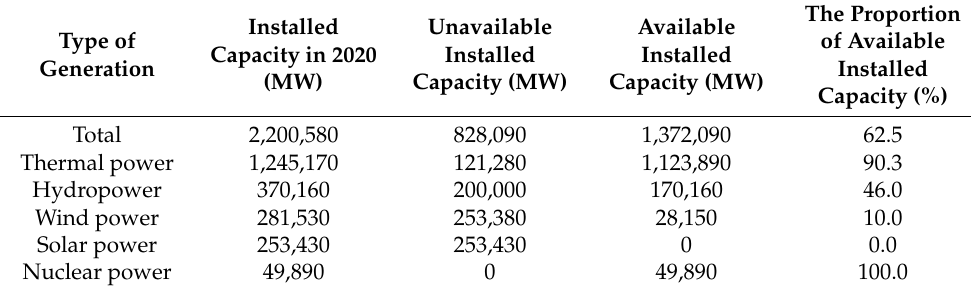
Table 5. Generation of various energy types on 7 January 2021.